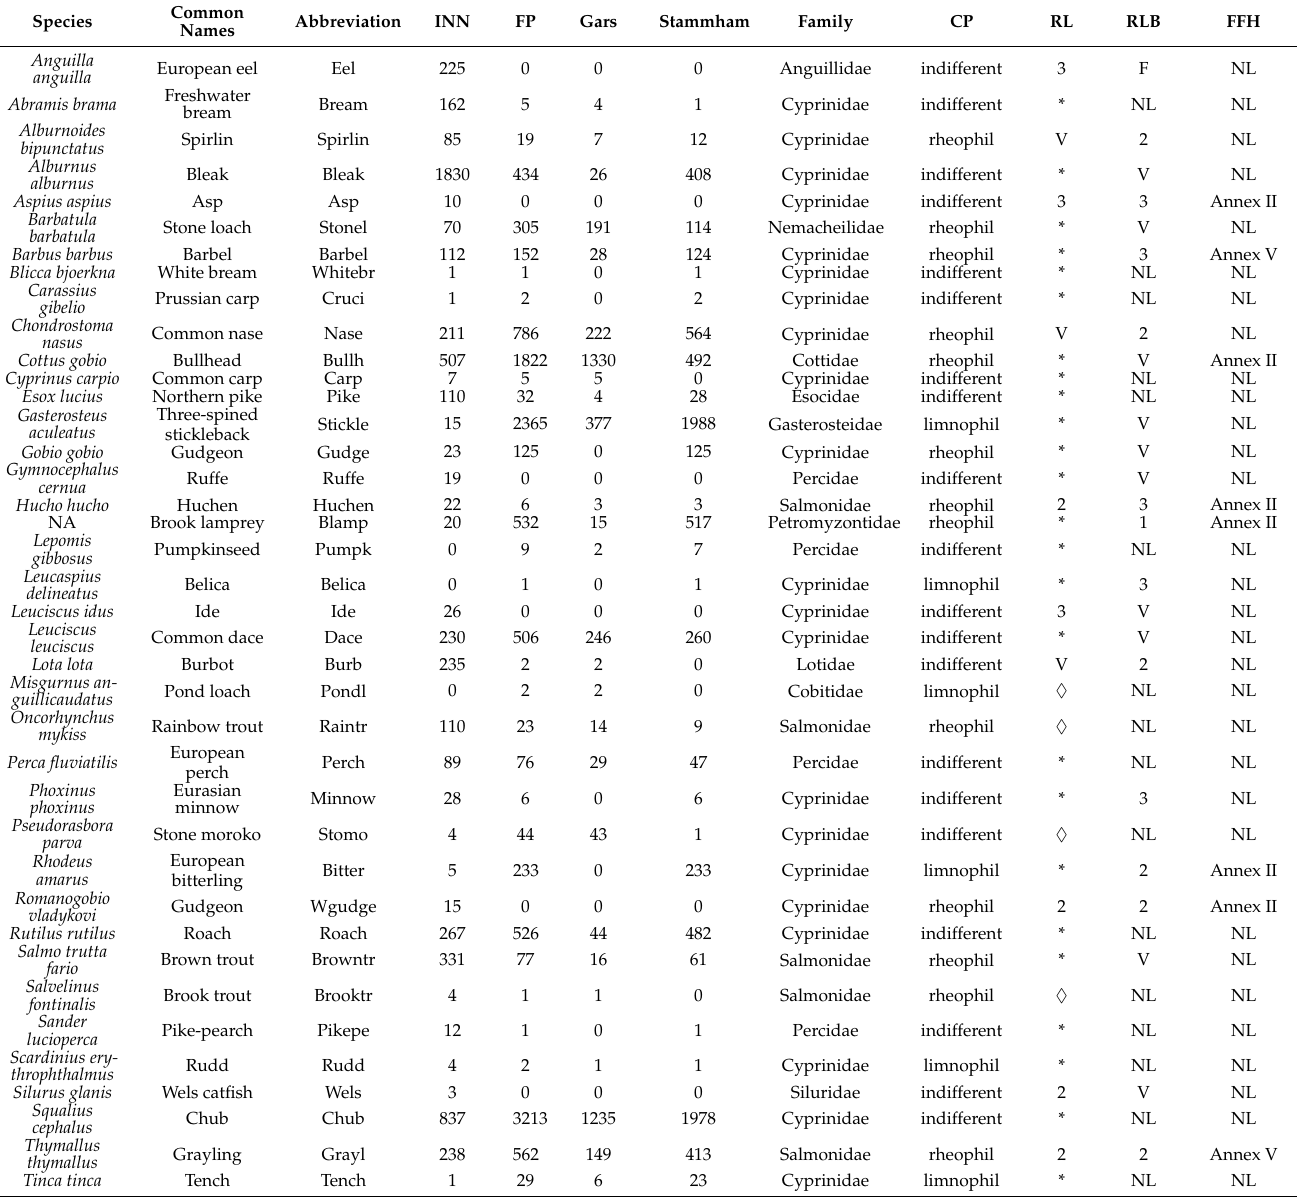
Table 6. List of detected species and their abbreviations used. INN = River Inn, FP = fish pass, CP = current preference, RL = Red List Germany, RLB = Red List Bavaria [43], FFH = protected species according to Flora Fauna Habitat Direction AnnexII and AnnexV [44]. Please note that the number of individuals are given as total catch numbers, which were not standardized to the length of sampled area